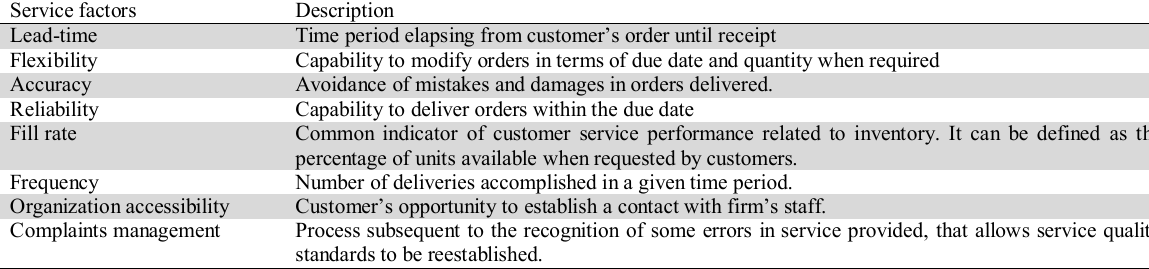
Service factors considered in the real case application